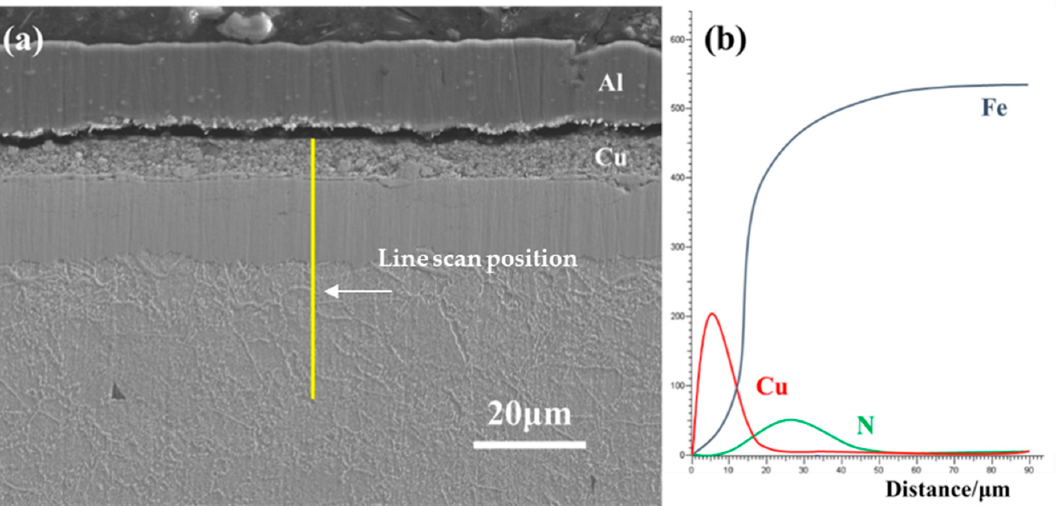
Figure 6. Nano-Cu/microalloyed gradient coating of 3# sample after in situ treatment observed by EPMA. ( a ) Cross sections and ( b ) linear scanning profiles.